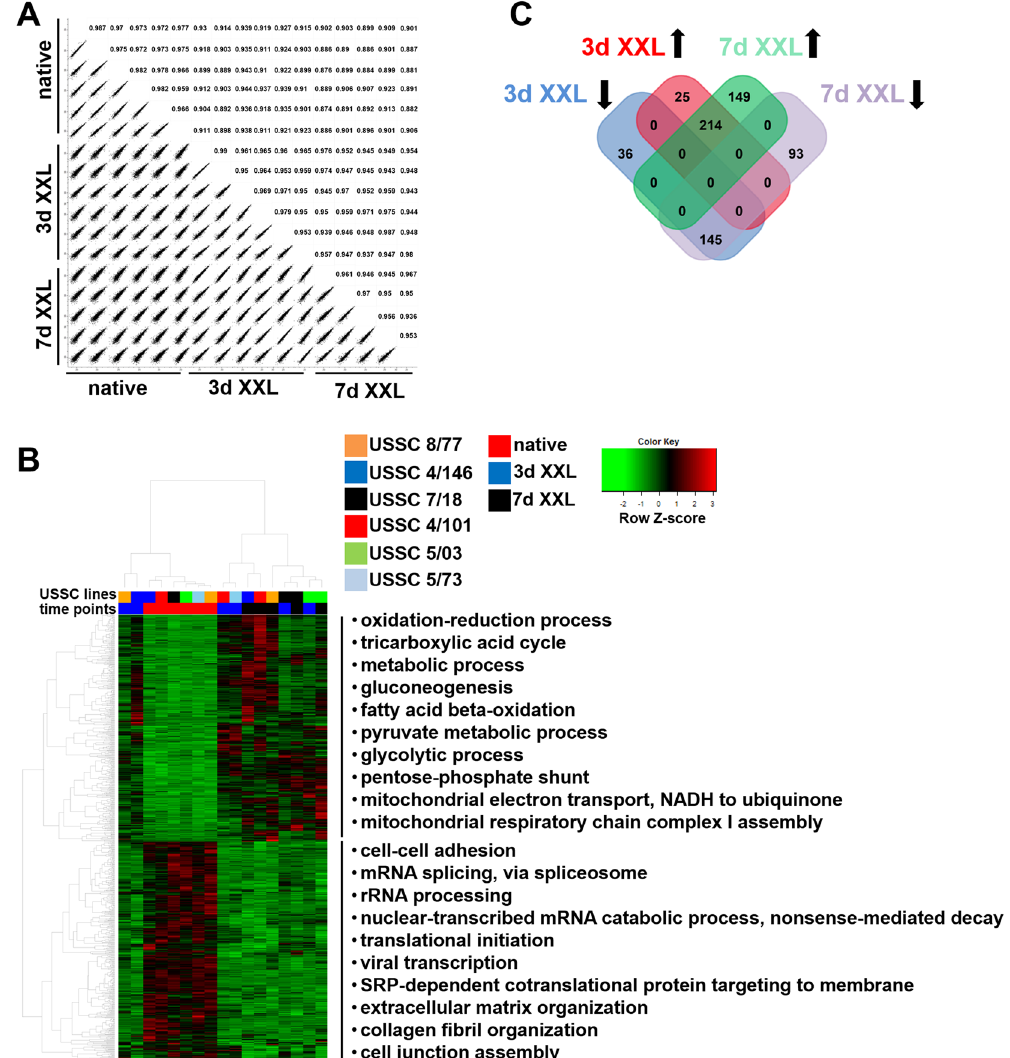
Figure 2. Proteome analysis of native and XXL-USSC. ( A ) Correlation plots of quantified proteins between native and XXL-treated USSC lines. Pearson’s correlations indicate a high similarity between the biological replicates. ( B ) Heat map of differentially abundant proteins in USSC lines 4/101, 4/146, 5/03, 5/73, 7/18, and 8/77 (p < 0.01, q < 0.05, FC > 1.5) at time points native, 3d, 7d, of XXL-incubation. USSC lines and time points are colour-coded at the top of the heat map. The heat map represents two main clusters of up- and downregulated proteins. Top categorical gene ontology enrichment annotations (q < 0.05) based on DAVID database are given (top 10 are shown). ( C ) Differentially abundant proteins at 3d and 7d XXL-USSC compared to native USSC. Black arrows denote the regulatory